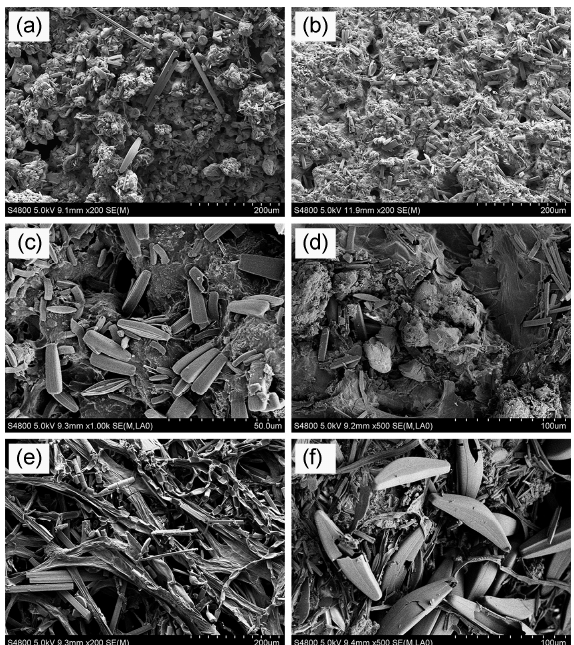
Figure 7. Scanning electron micrographs of tested samples showing superficial deposit characteristics. ( a ) Some diatoms on the porous tufa surface, S PL ; ( b ) Porous calcareous deposit surface with diatoms, S PS 2; ( c ) Diatoms of Fragilaria and Navicula on loose deposits, S PS 1; ( d ) Diatoms ( Fragilaria ) embed in loose deposits, S PS 3; ( e ) Dense growths of diatoms ( Fragilaria and Melosira ) produce a mat composed of interwoven stalks that cover the deposits completely, S ABL ; ( f ) Diatom ( Cymbella ) communities cover the deposits fully, S SZL .